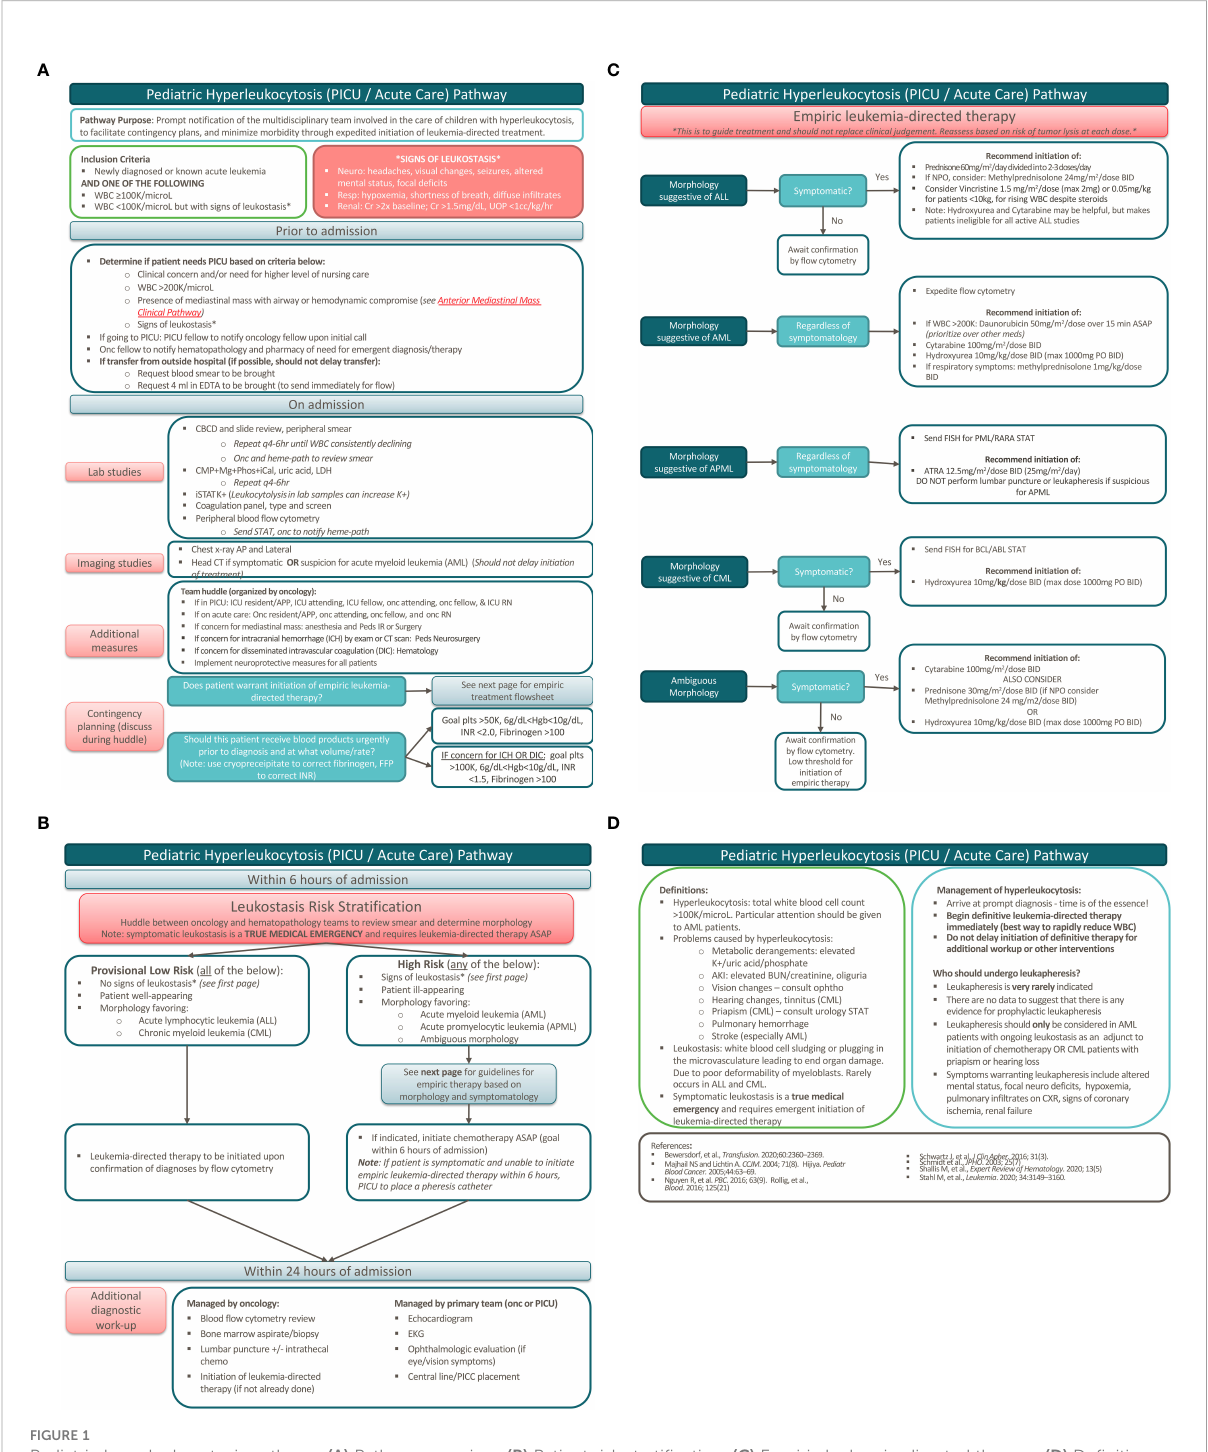
FIGURE 1 Pediatric hyperleukocytosis pathway. (A) Pathway overview. (B) Patient risk strati fi cation. (C) Empiric leukemia-directed therapy. (D) De fi nitions and additional